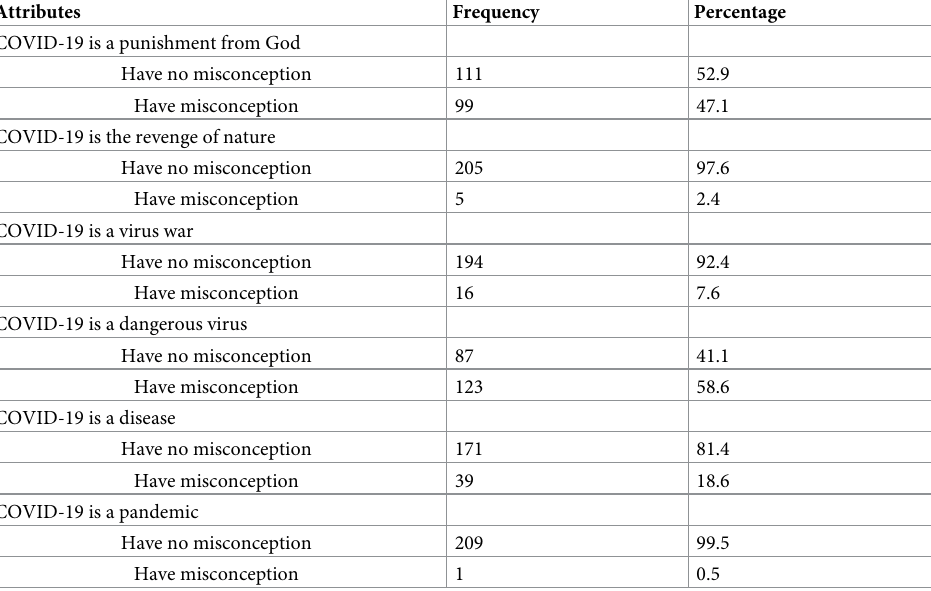
Table 2. Common COVID-19 related misconception among rural people in Satkhira district- Bangladesh, 2020.